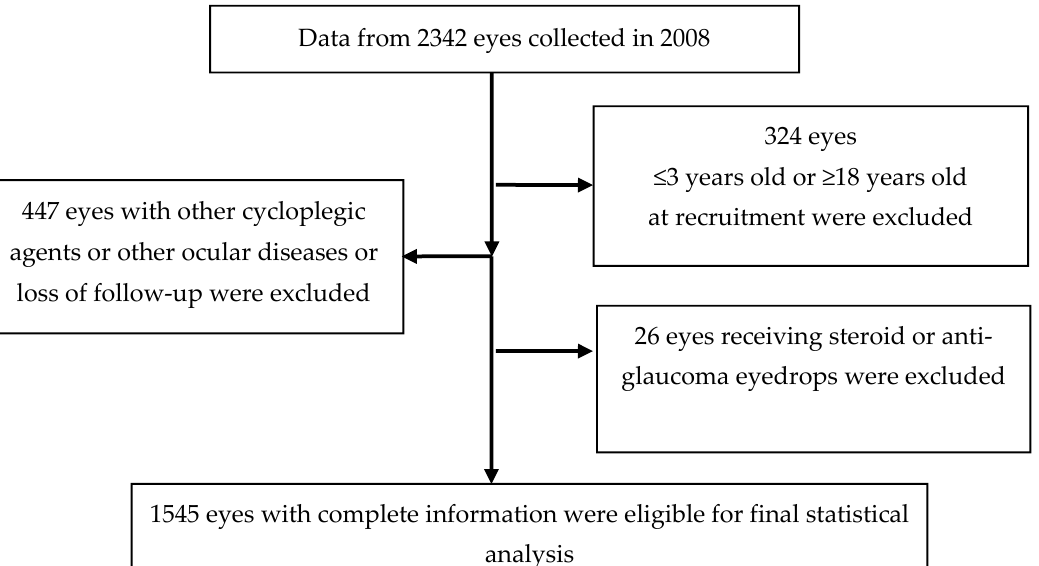
Figure 1. Algorithm of case identification.